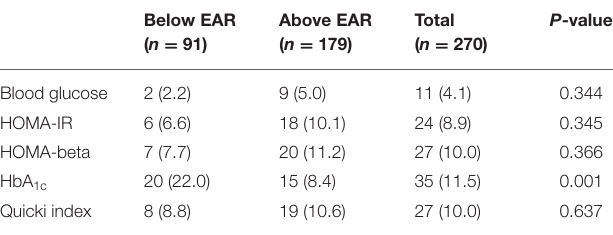
TABLE 3 | Disturbances in biomarkers of glycemic control of individuals with Normal-Weight Obesity Syndrome, according to dietary selenium